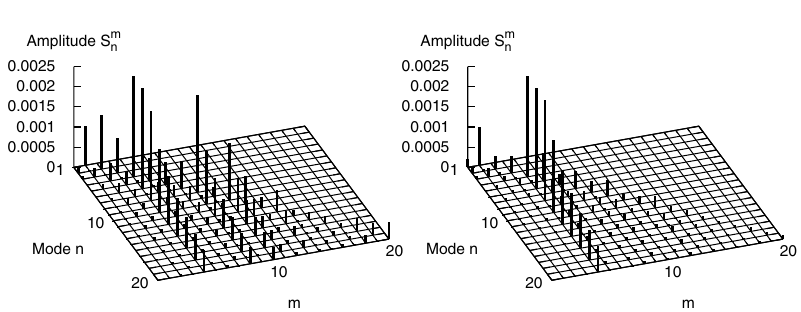
for the (c) zero- i